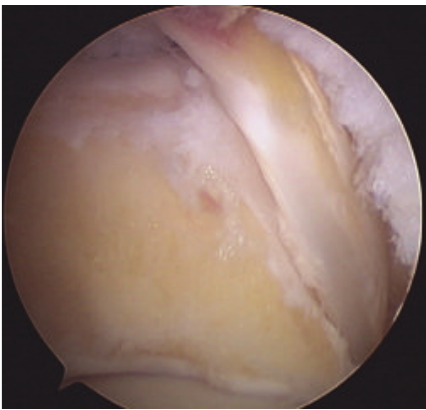
Figure 6: Complete